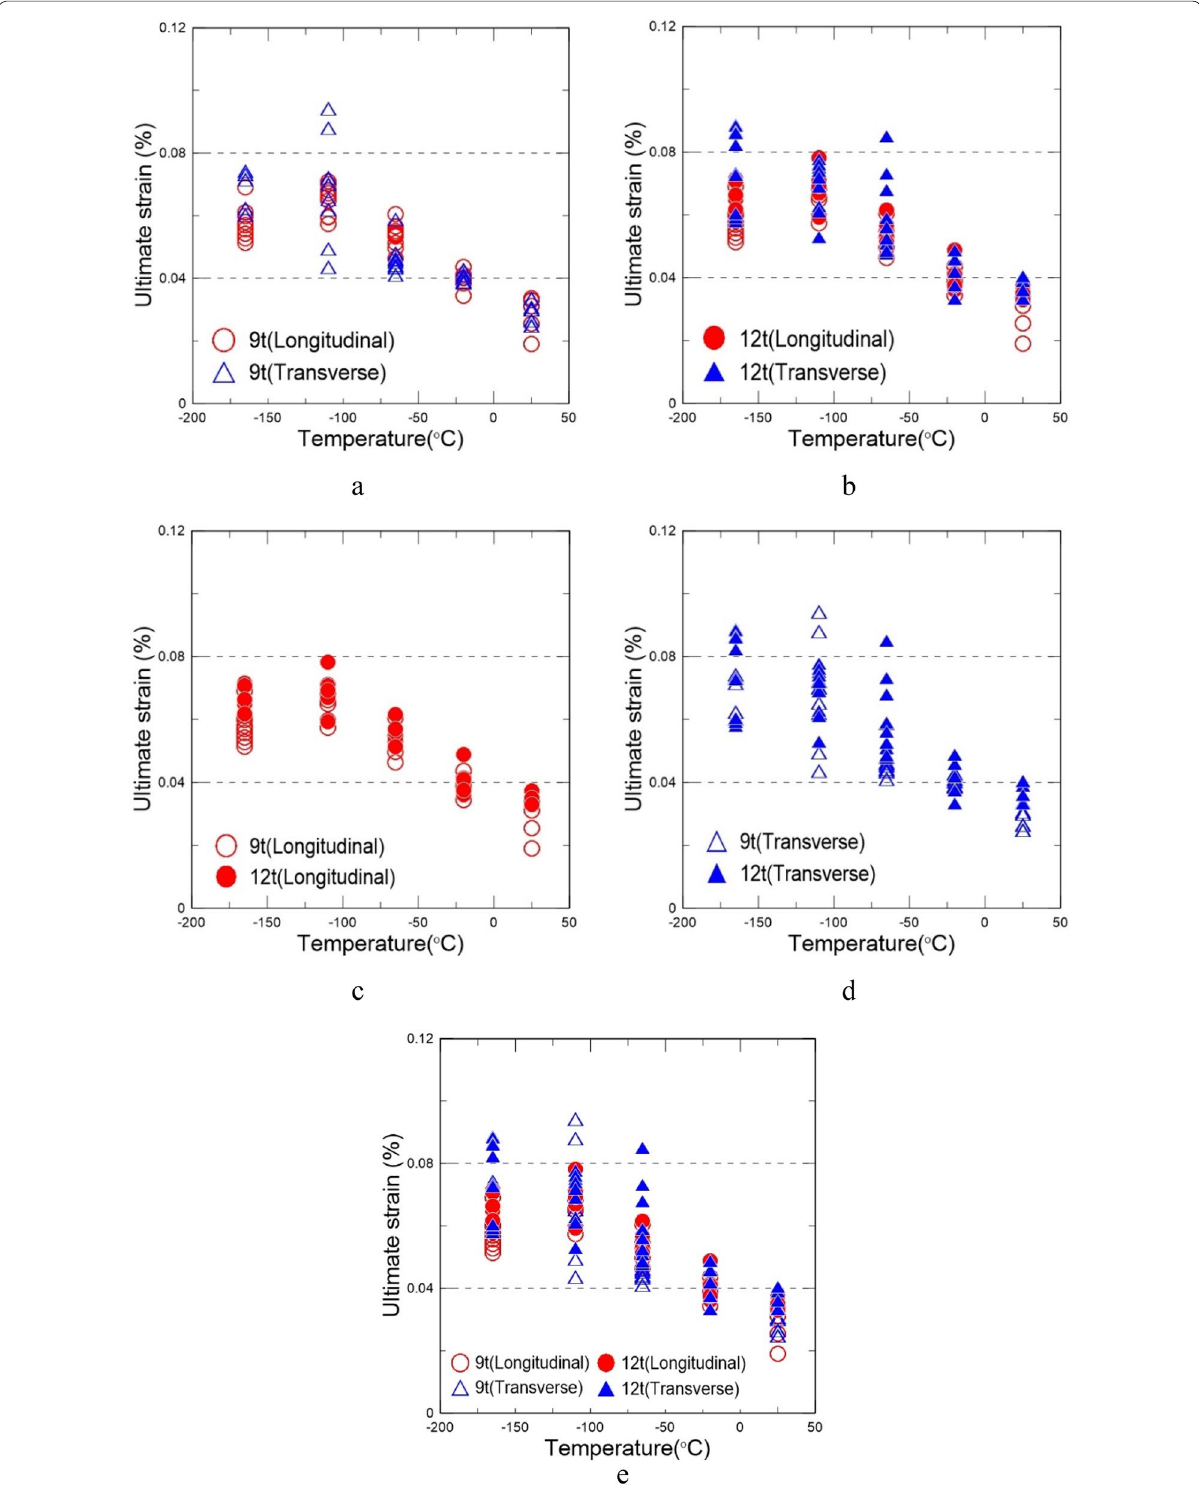
Fig. 18 Ultimate strain of 9t and 12t plywoods in longitudinal and transverse fiber directions: a 9t, b 12t, c longitudinal fiber direction, d transverse fiber direction, and e overall